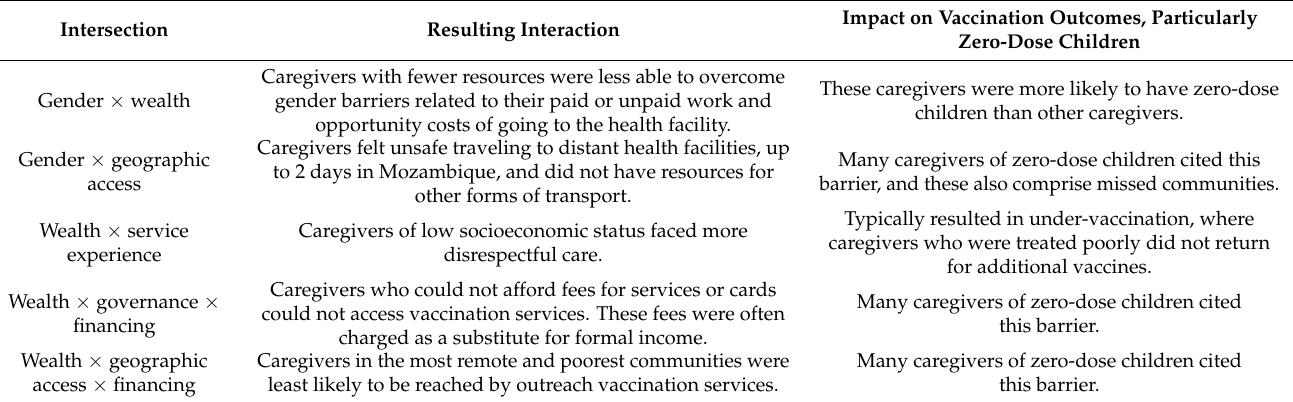
Table 4. Examples of findings through the intersectionality